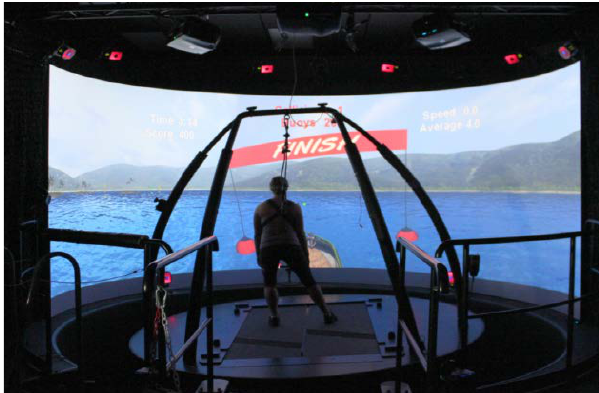
Figure 1. A subject navigates a boat through a virtual scene in the